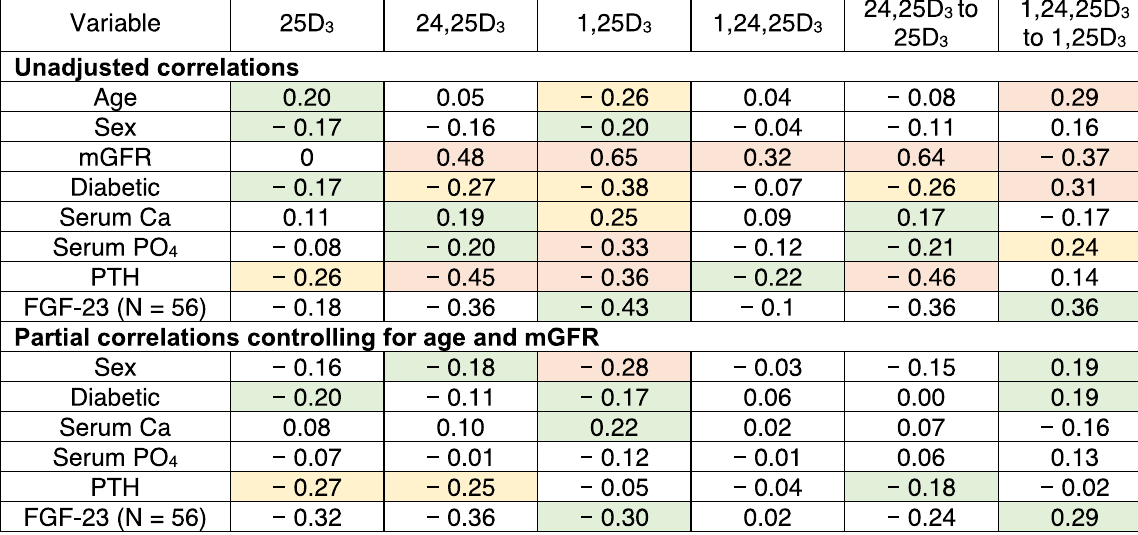
Table 2. Spearman correlations of vitamin D metabolites with demographics and serum measures in participants unadjusted and partially adjusted controlling for age and mGFR. Spearman r value indicated.